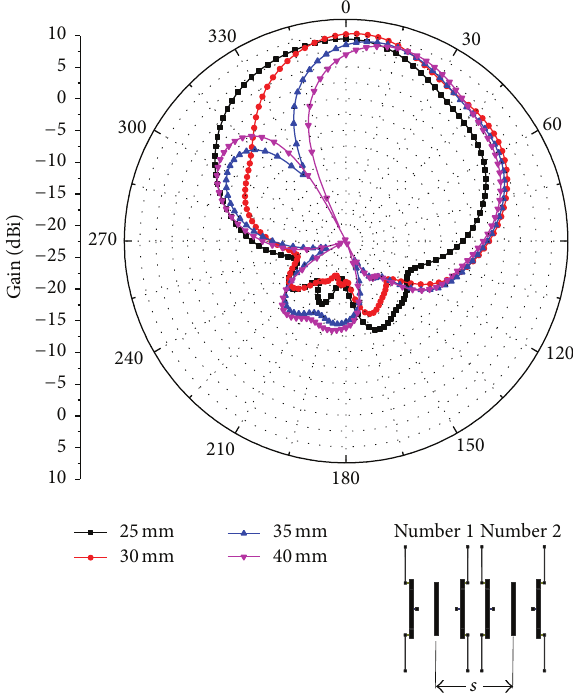
Figure 4: Parameter study of the distance between two